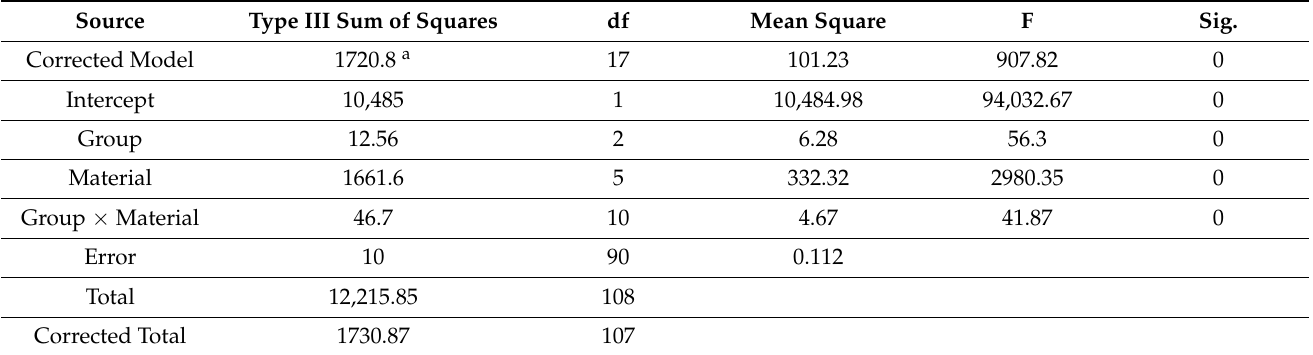
Table 2. Two-way ANOVA (Tests of Between-Subjects Effects).